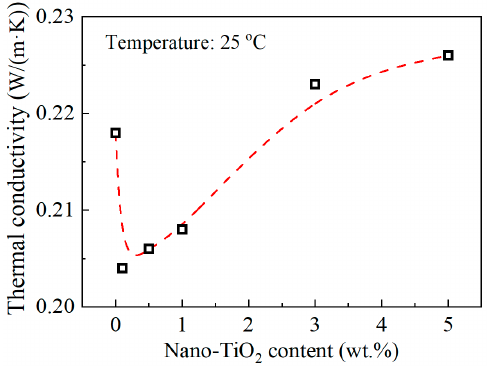
Figure 6. Thermal conductivity and nano-TiO 2 content at 25 °C.